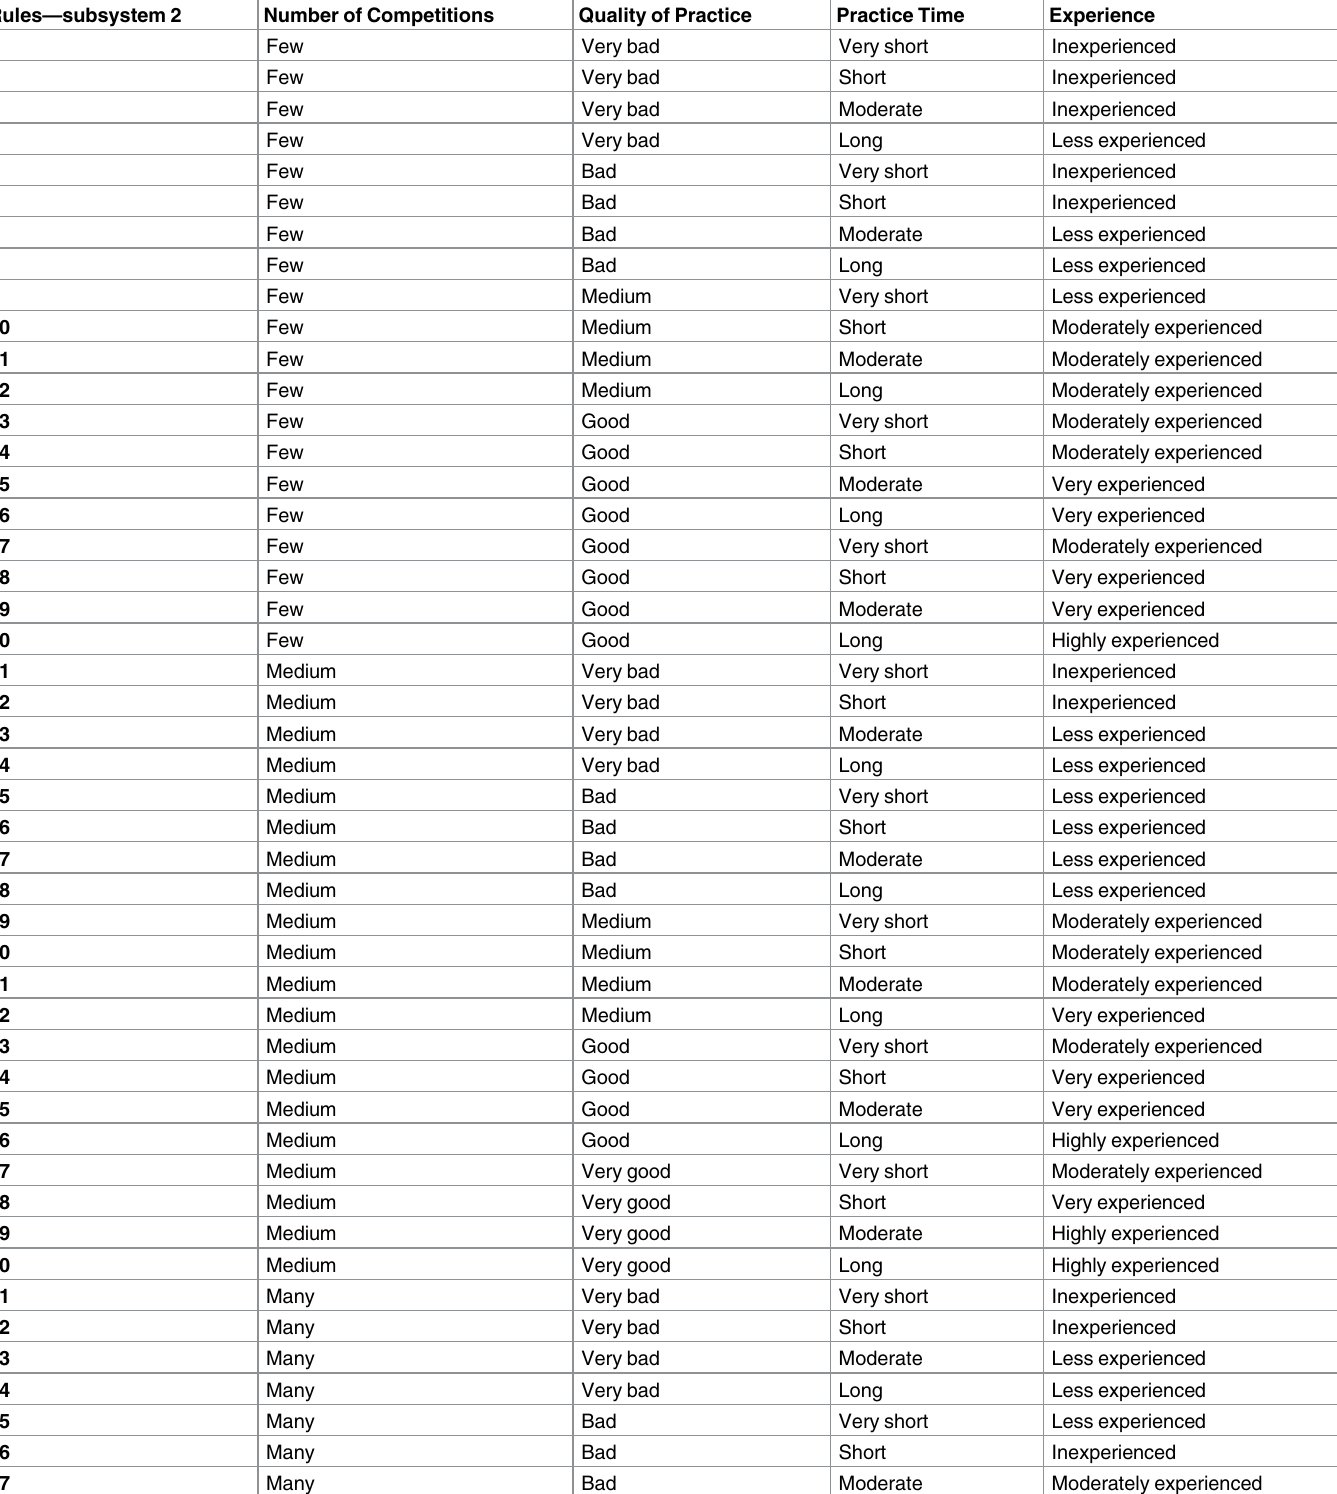
Table 2. Rules used in the subsystem2 –experiencelevel. Rules—subsystem